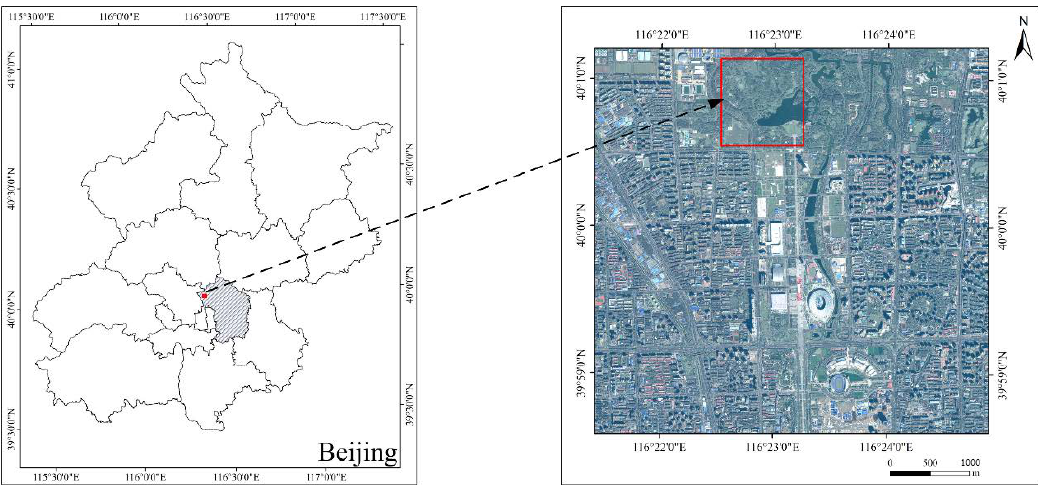
Figure 1. Location of the research area.